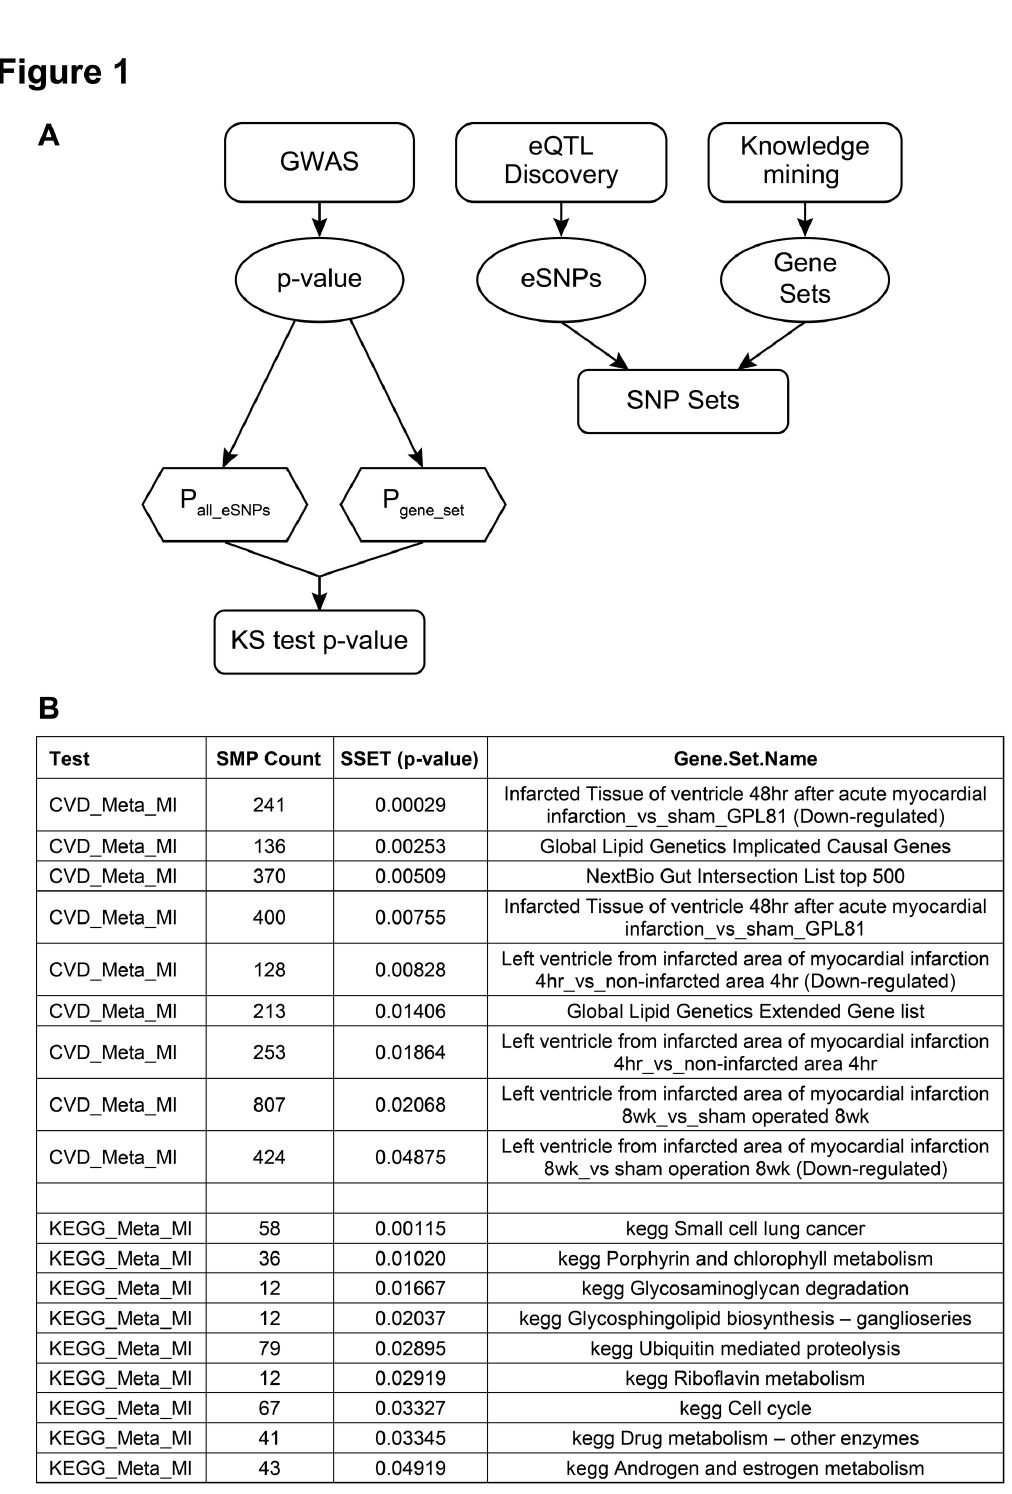
Figure 1. SNP set enrichment test work flow. A : 100 gene sets derived from mRNA profiling signatures, gene expression networks and other sources relevant to dyslipidemia and cardiovascular disease were assembled. Each gene set was sequentially tested against the associations identified for the phenotype of interest. For each gene set, multiple eSNPs representing the genes in that gene set were tested as a group for association to the trait of interest using a Kolmogorov-Smirnov test. B : Gene sets corresponding to Kegg pathways were also tested for the phenotype of MI. doi: 10.1371/journal.pone.0085369.g001 PLOS ONE |